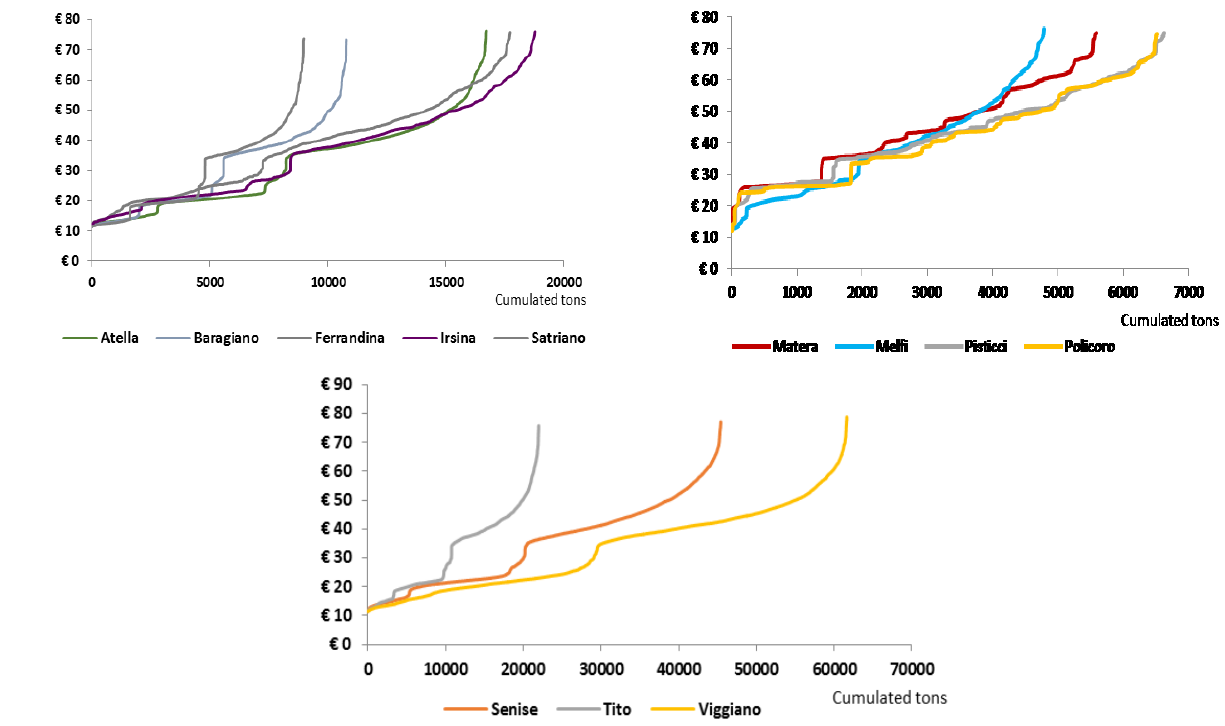
Figure 7. Cost supply curves of supply